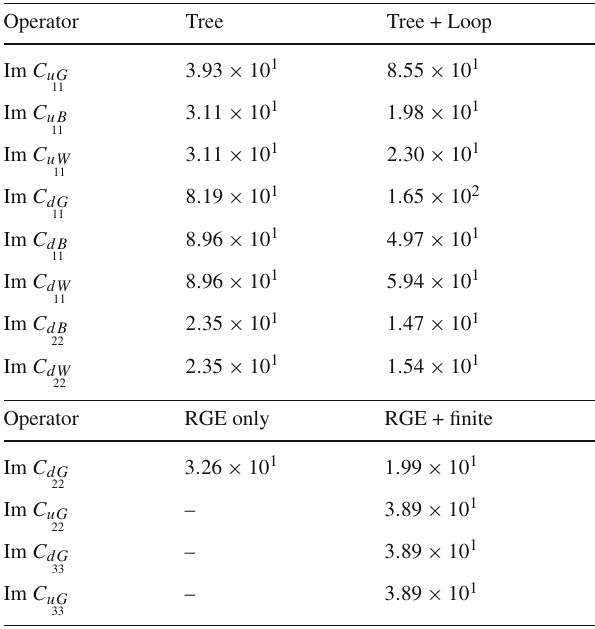
Table 9 Lower bounds on the UV scale (cid:2) in TeV assuming natural scaling of the dipole Wilson coefficients and no further assumptions. On the left-hand side the coefficients are presented which can enter at tree level. The column ‘Tree+Loop’ presents bounds including the tree level contribution, the RG running and all finite terms. On the right- hand side one can find all elements which cannot enter at tree level. The left column shows only RG running, while the right column shows both